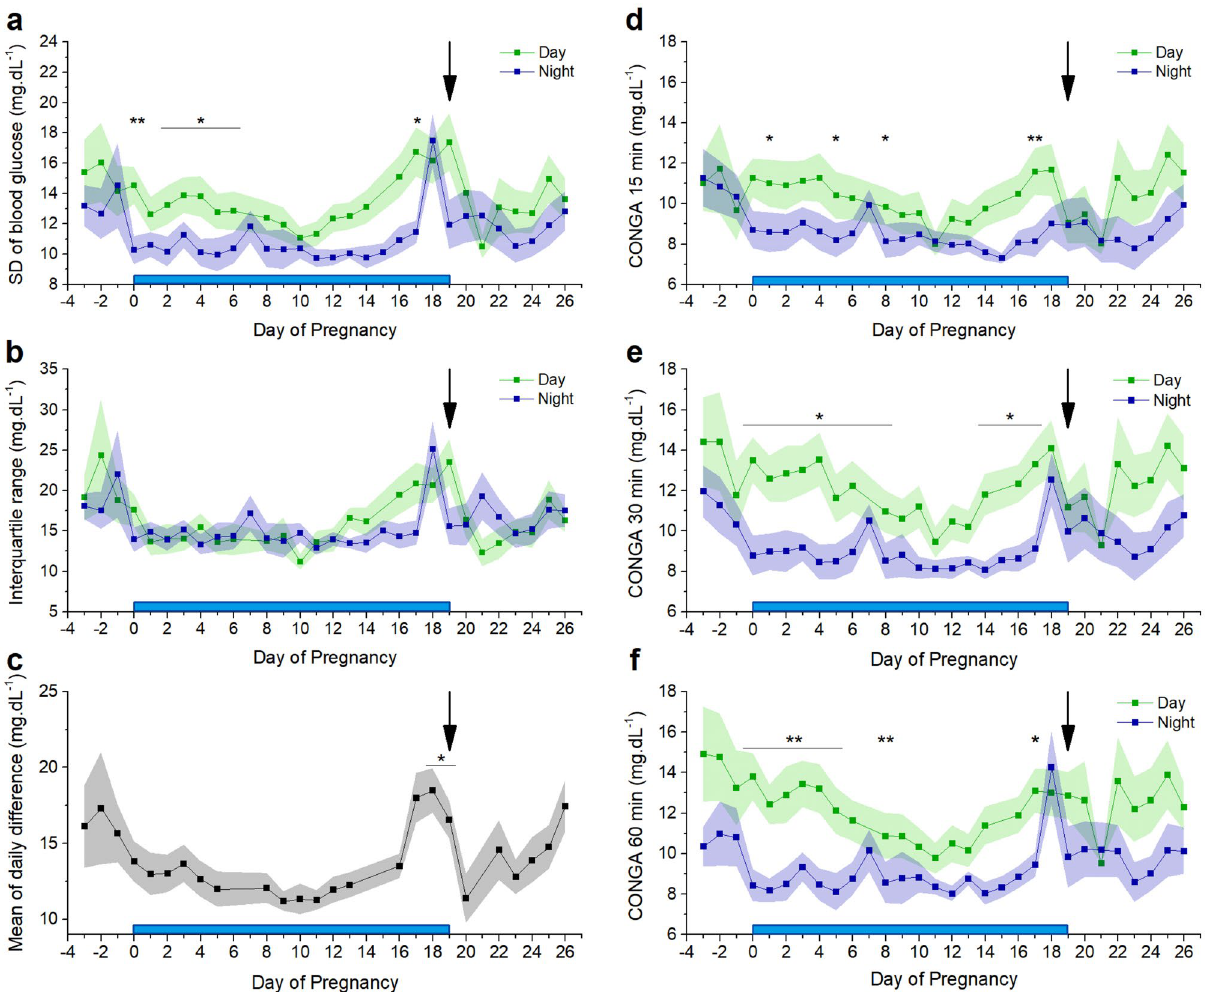
Figure 8. Parameters of glycaemic variability. Blue bar: time of pregnancy. Black arrow: delivery. ( a ) The mean standard deviation ± s.e.m. of blood glucose (SDBG) (paired t-test corrected for multiple comparison). ( b ) The mean ± s.e.m. interquartile range (IQR) ( c ) The mean of daily differences (MODD) ± s.e.m. for 24 h (One way repeated measures ANOVA on the results from day 0–19, p = 6.7 × 10 –15 and post hoc pairwise comparison with Bonferroni correction. ( d ) Continuous overlapping net glycaemic action (CONGA) mean ± s.e.m. over 15 min (paired t-test corrected for multiple comparison). ( e ) CONGA mean ± s.e.m. over 30 min (paired t-test corrected for multiple comparison). ( f ) CONGA mean ± s.e.m. over 60 min (paired t-test corrected for multiple comparison). (n = 10